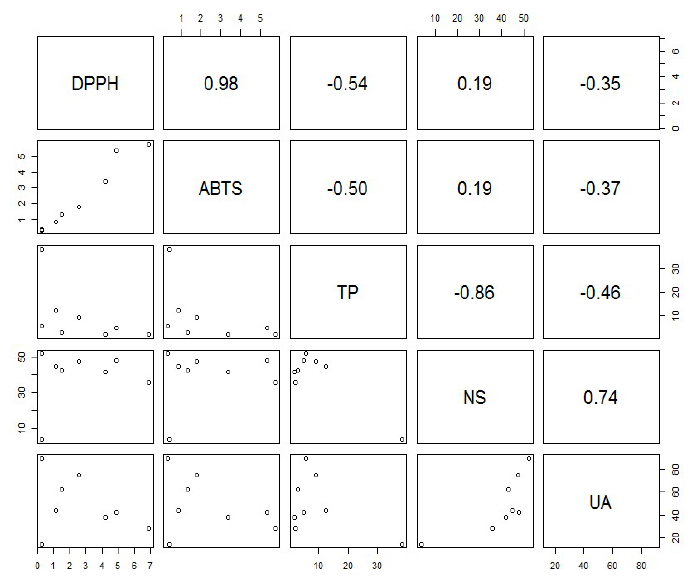
Figure 3. Pearson’s correlation coefficients between antioxidant activity (DPPH, ABTS) and total phenols (TP), neutral sugars (NS) and uronic acids (UA) content.